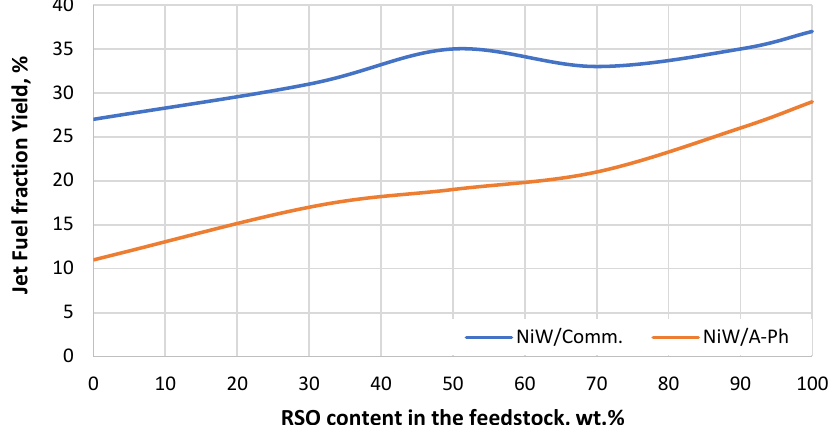
RSO content in the feedstock, wt.%